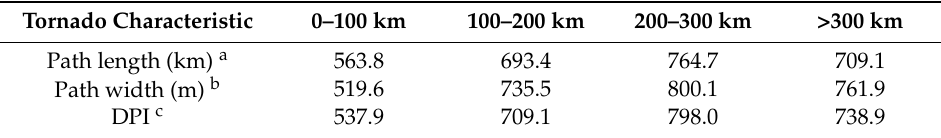
Table 4. Mean ranks used in the Kruskal-Wallis tests for the 0–100 km, 100–200 km, 200–300 km, and >300 km regions. Results of the Kruskal-Wallis tests are located below the table. Post-hoc pairwise comparisons indicate that, for all three variables, the mean ranks of the 100–200 km, 200–300 km, and >300 km regions are significantly greater than the mean ranks of the 0–100 km region.